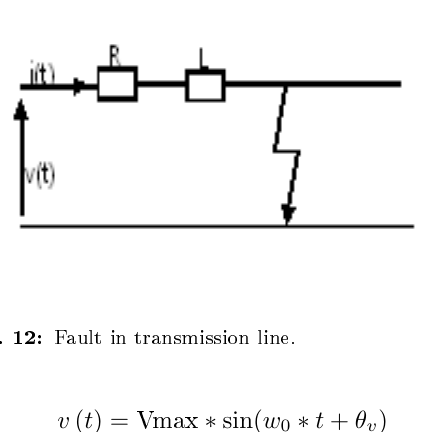
Fig. 11: Fault location as function of time using the re- actance.